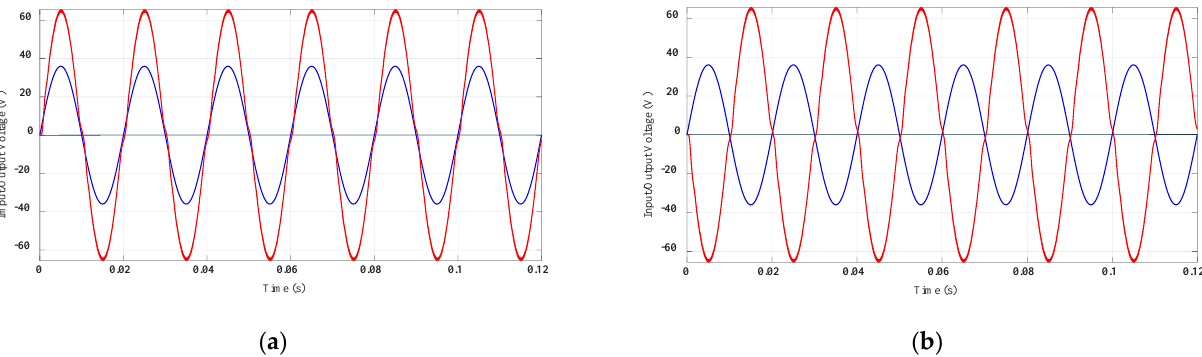
Figure 11. Computer simulation results of output voltage (red) with respect to input (blue) for output step-up process in ( a ) non-inverted form and ( b ) inverted form.